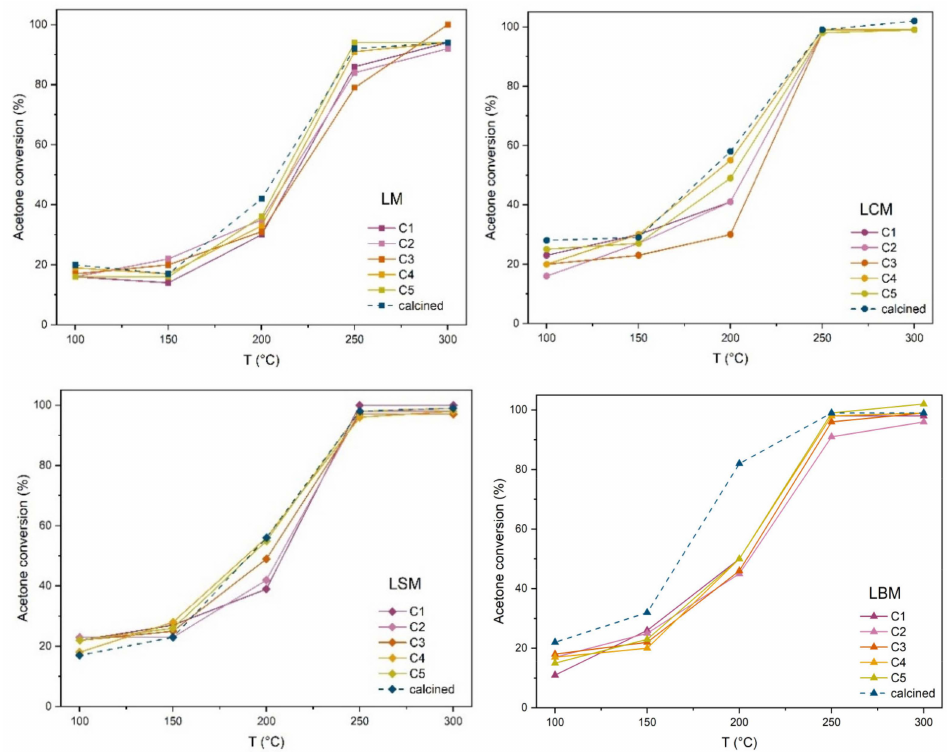
Figure 3. Acetone conversion of LM, LCM, LSM and LBM over five consecutive cycles compared with conversion of LM750, LCM750, LSM750 and